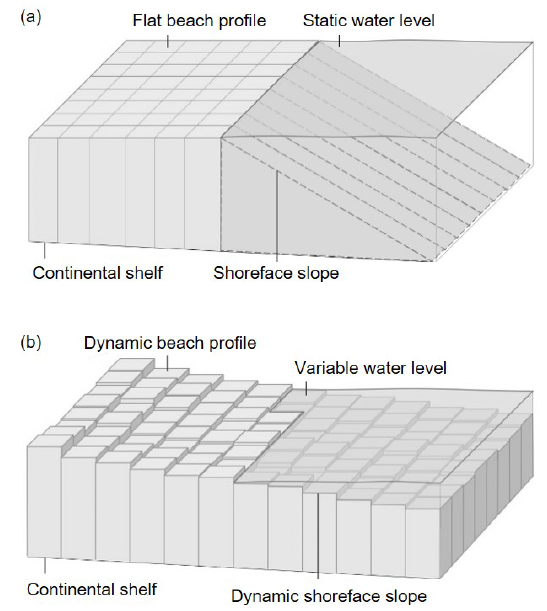
Figure 4. Schematics of the profiles of CEM (a) and CEM2D (b) , illustrating the difference in structure and dimensionality of the two